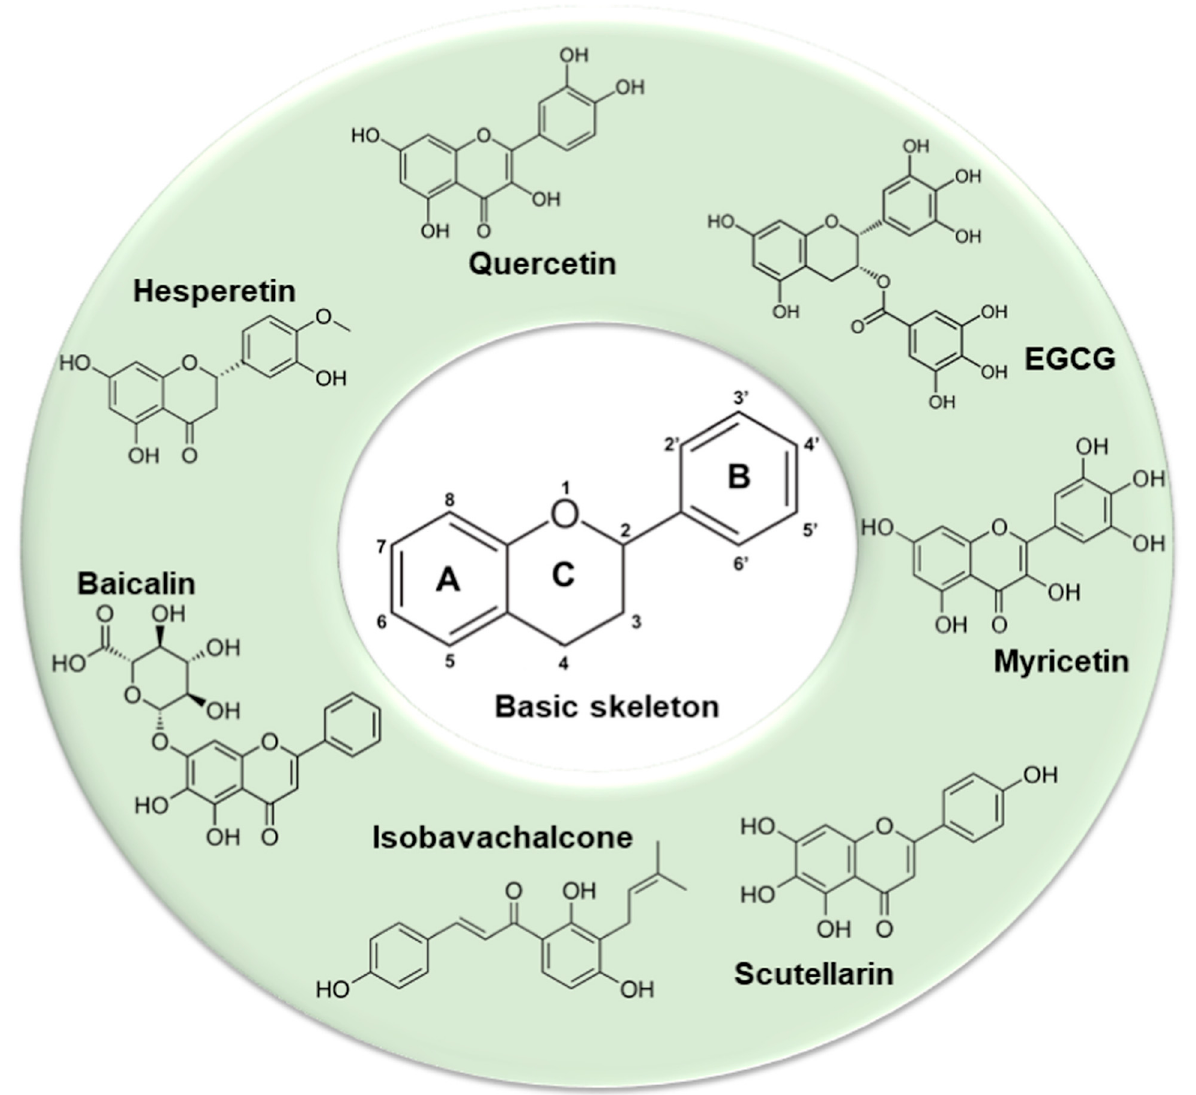
Figure 1. Basic skeleton (C6–C3–C6) of flavonoids and representative examples of compounds able to counteract coronavirus infection. (Reproduced from [111]).